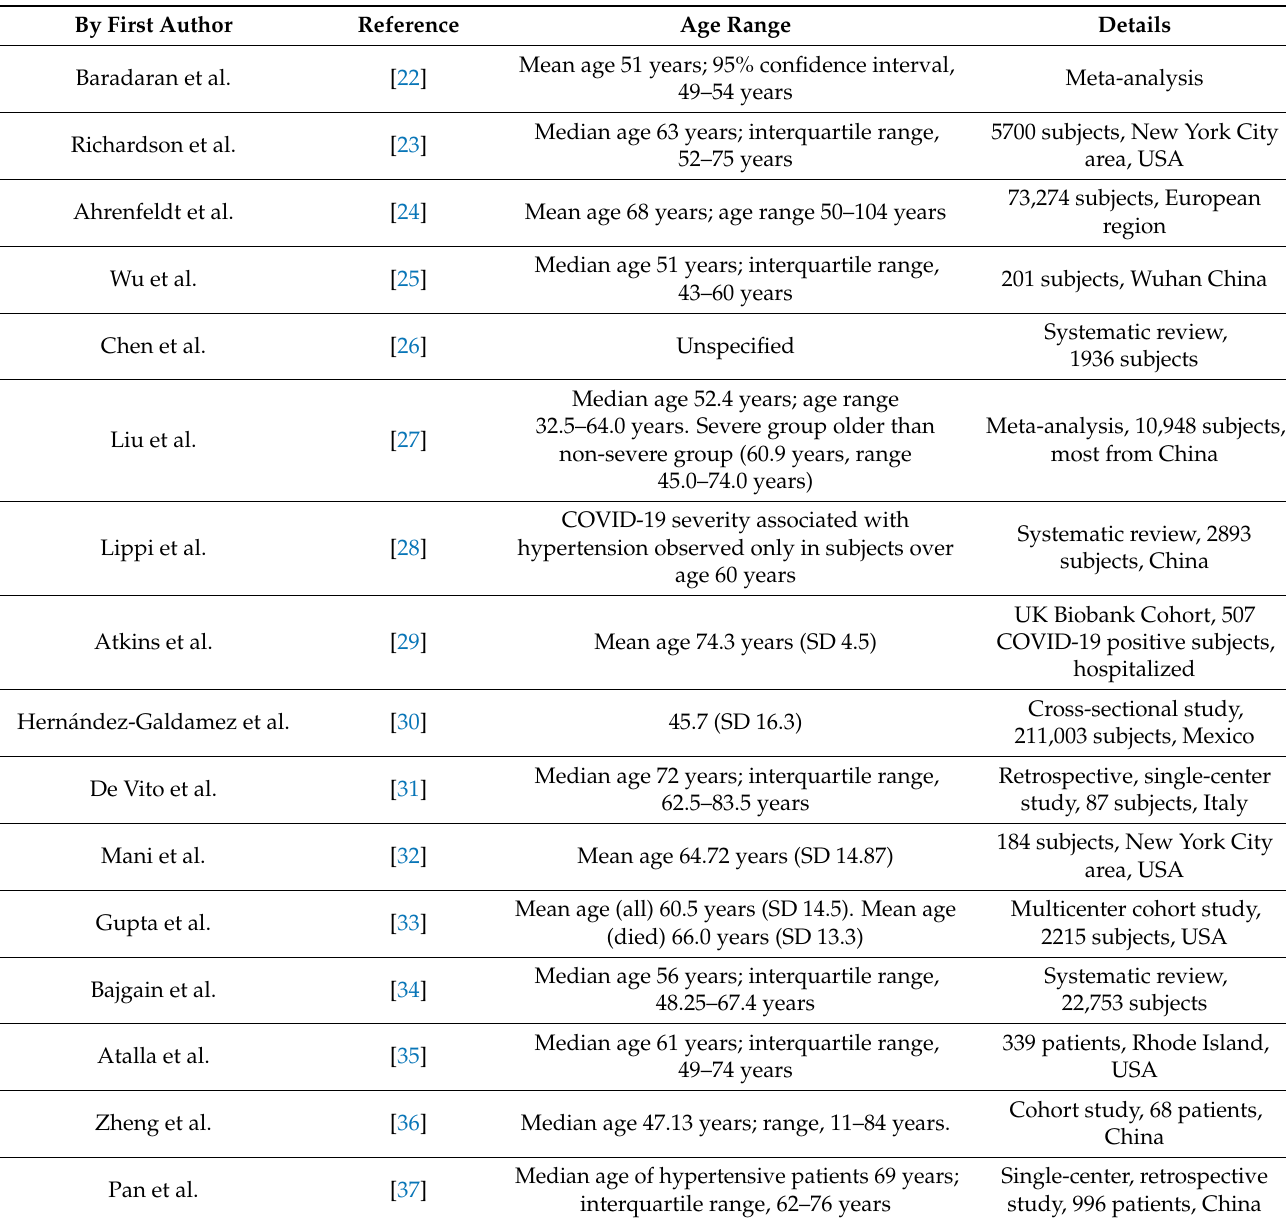
Table 1. Hypertension and COVID-19 studies, with age